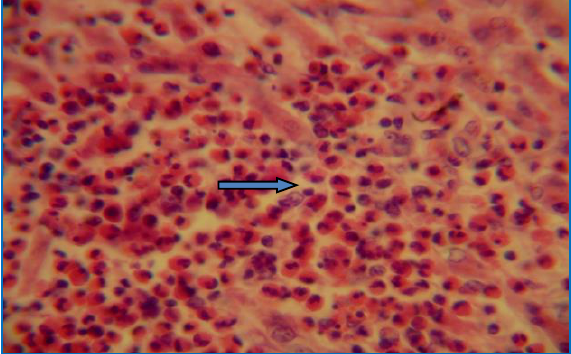
Figure, 6: G2: Liver of rabbit at 30 days post infection show marked interlobular fibrosis ( ) with vacuolar degeneration of hepatocytes ( ) (H and E 40x).